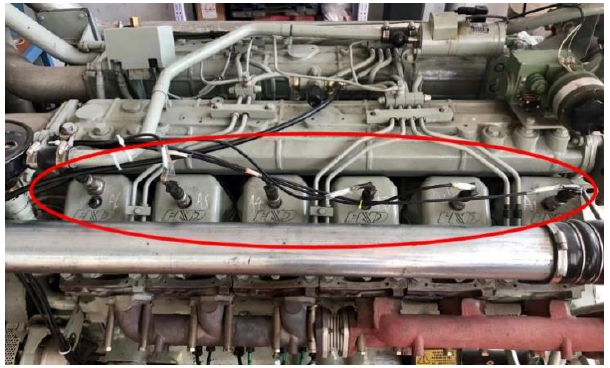
Figure 2. Installation diagram of the cylinder head accelerometer. Table 2. The main parameters of the acceleration sensor.